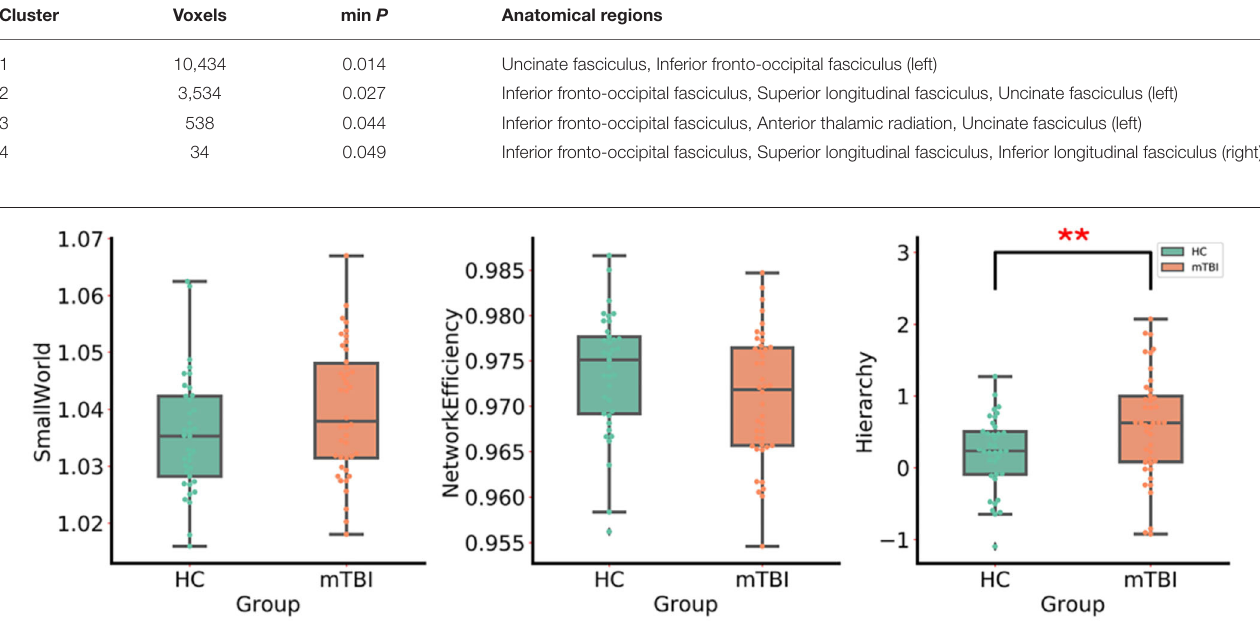
mTBI group was positively correlated with the MMSE scores ( r = 0.378, p = 0.014) ( Figure 4C